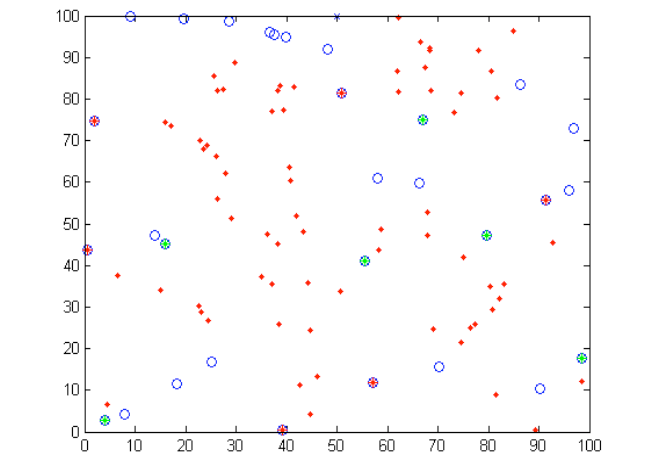
Fig. 4. Simulation with EDE